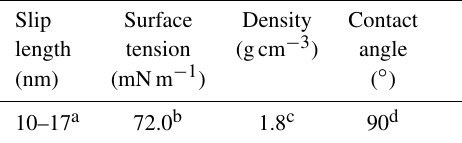
Table 3. Physical parameters used in COMSOL simulations to simulate a lower limit of viscosity for poke-and-flow experiments where particles were observed to crack when impacted by the nee- dle, and where no observable flow of material was observed over the course of the